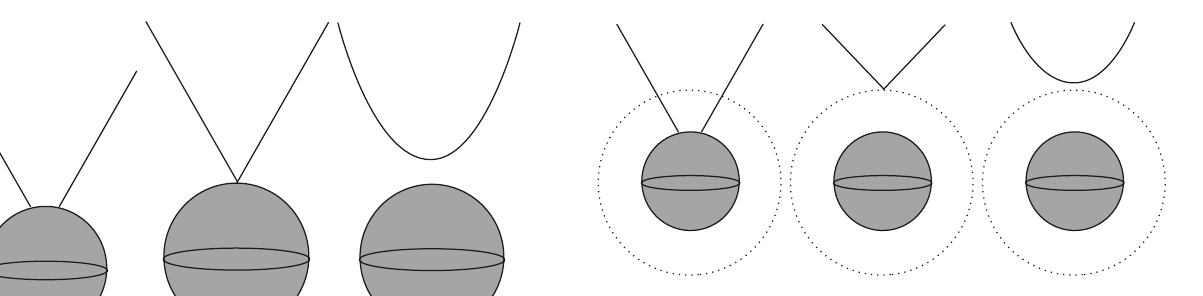
Figure 10: With a nonvanishing electric field, the new radial location 𝑟 ∗ emerges, which is shown as the dashed circular curve above. In this case, also, the embedding functions can be divided into two categories, separated by a critical one. The critical curve is subtle to define, since the conical singularity in the critical curve of Figure 9 can occur either at the location of the background event horizon,orat 𝑟 ∗ .Here,wewillchoosethelatter,whichwillbefurther justified